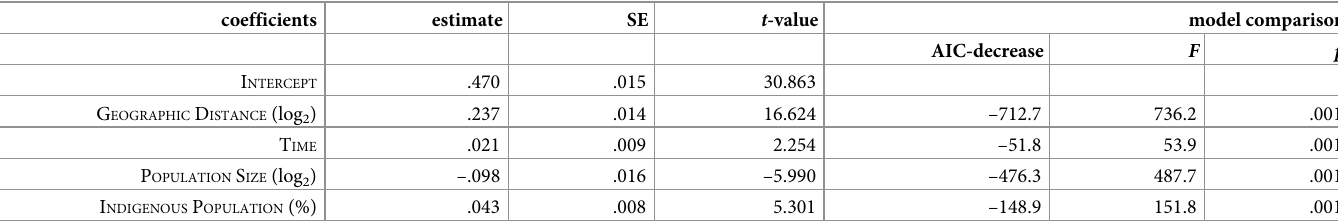
Table 2. Linear mixed-effects model on the D ISSIMILARITY between speakers ( n =